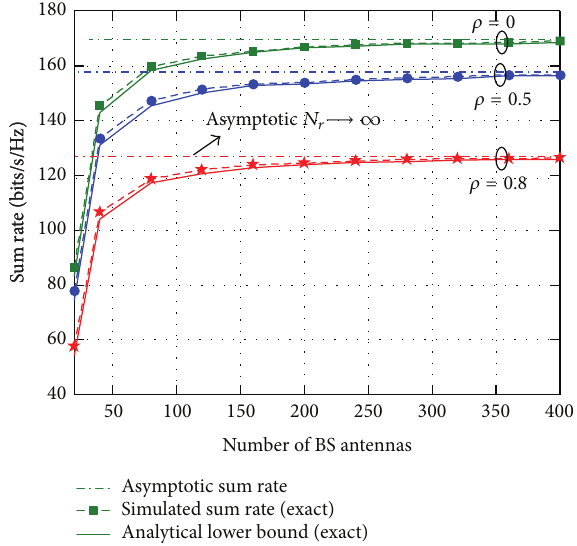
Figure 6: Analytical sum rate and lower bound versus the number of BS antennas ( 𝛾 = 10/𝑁 𝑟 dB, 𝑁 𝑡 = 2 , 𝐾 = 9 , 𝜌 = 0, 0.5 , and 0.8 ).